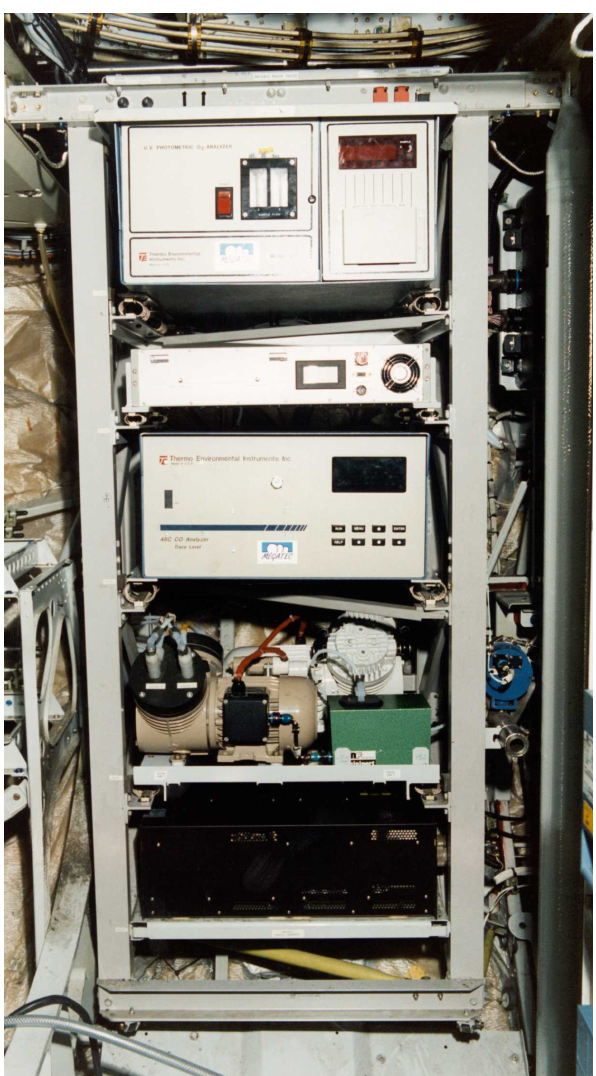
Figure 2. Picture of the MOZAIC system located on a A340 star- board side. See text for a brief